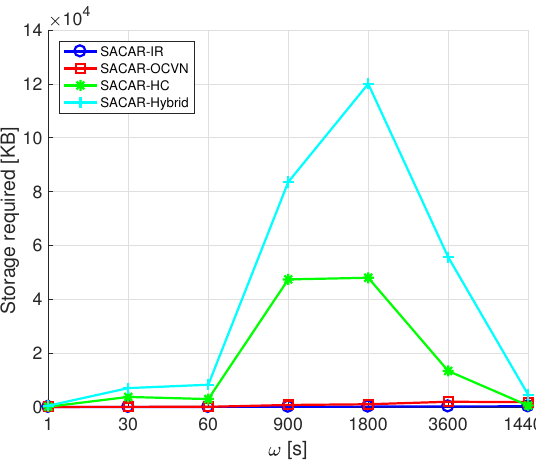
Figure 5. Storage required for the SACAR